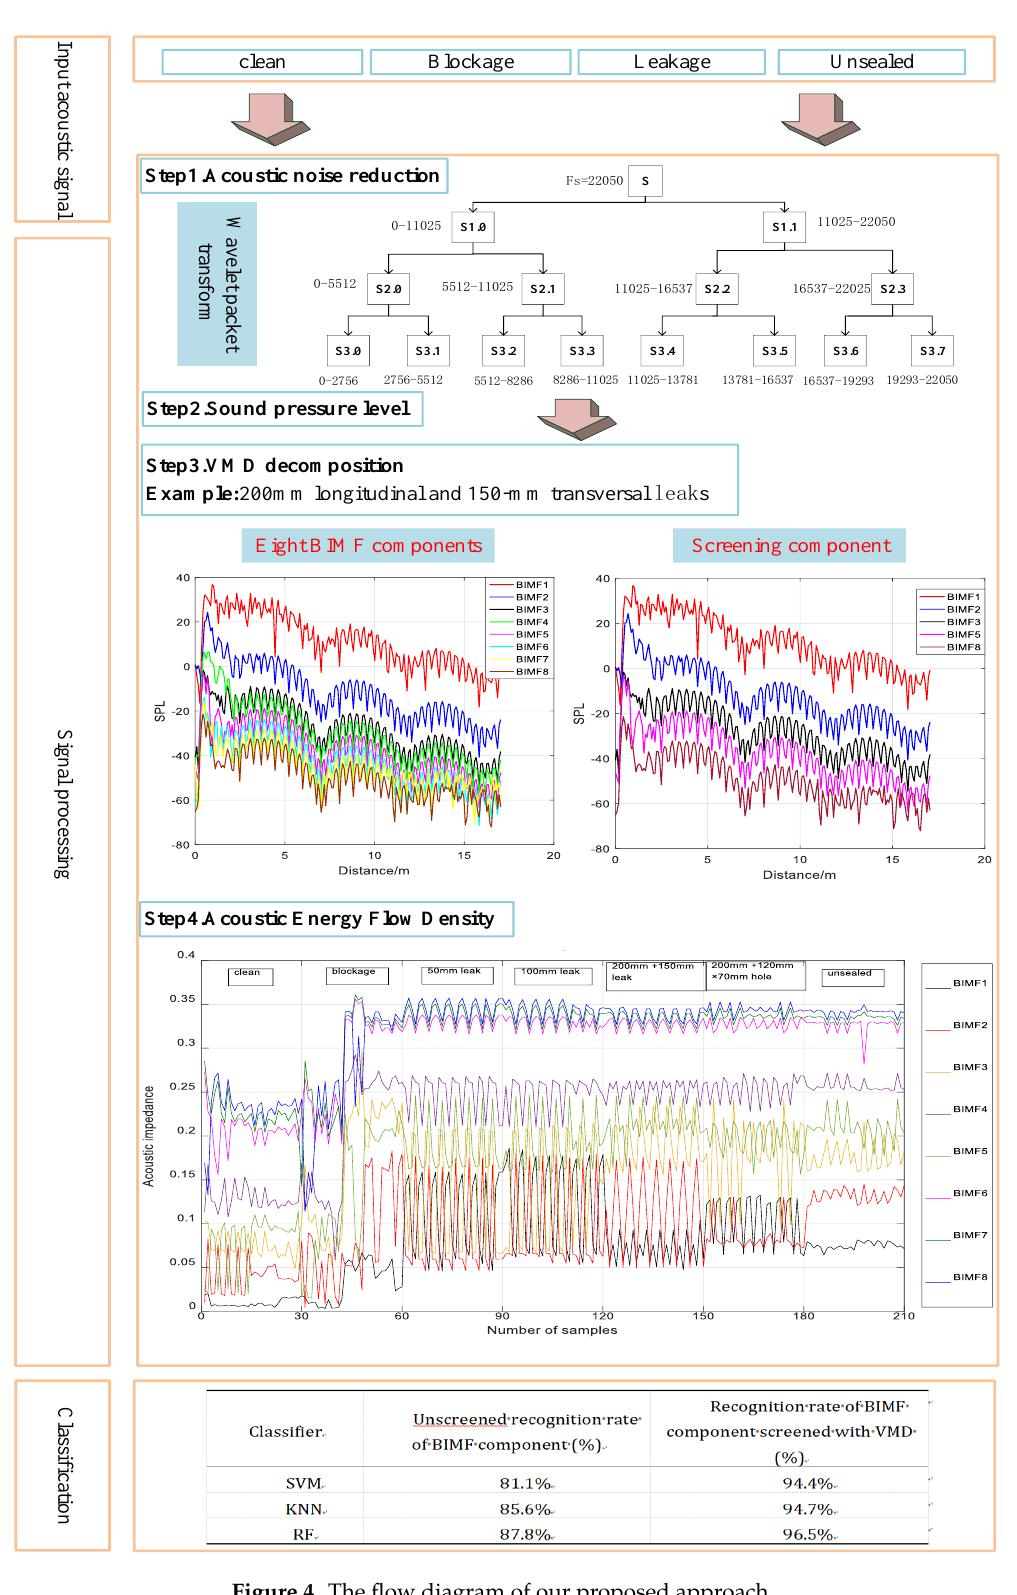
Figure 4. The flow diagram of our proposed approach.